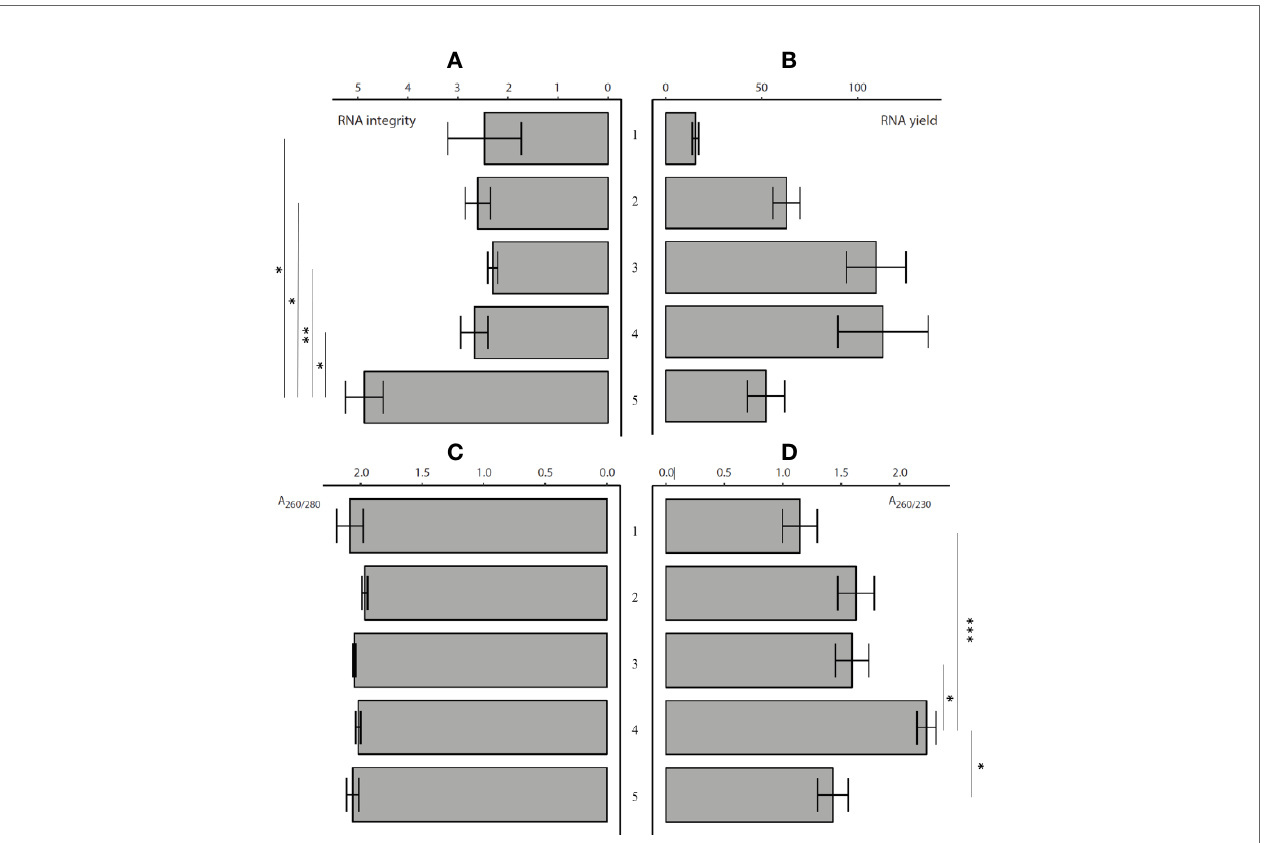
FIGURE 2 | The comparison of RNA extraction protocols (n = 3) at the level of: (A) RNA integrity, (B) RNA yield (ng/µl), (C) A 260/280 purity, and (D) A 260/230 purity [Error bars indicate mean (µ) ± standard error of mean (SEM)]. (1) RNeasy ® Plant Mini Kit ac. Sangha, (2) Spectrum ™ Plant Total RNA Kit ac. Sangha, (3) InviTrap ® Spin Plant Mini Ki ac. Sangha, (4) Reliaprep ™ RNA cell Miniprep System ac. Sangha, and (5) 3% CTAB protocol (Luypaert et al., 2017). *p < 0.05, **p <0.01, ***p < 0.001. More details on signi fi cance can be found in Supplementary Table S4